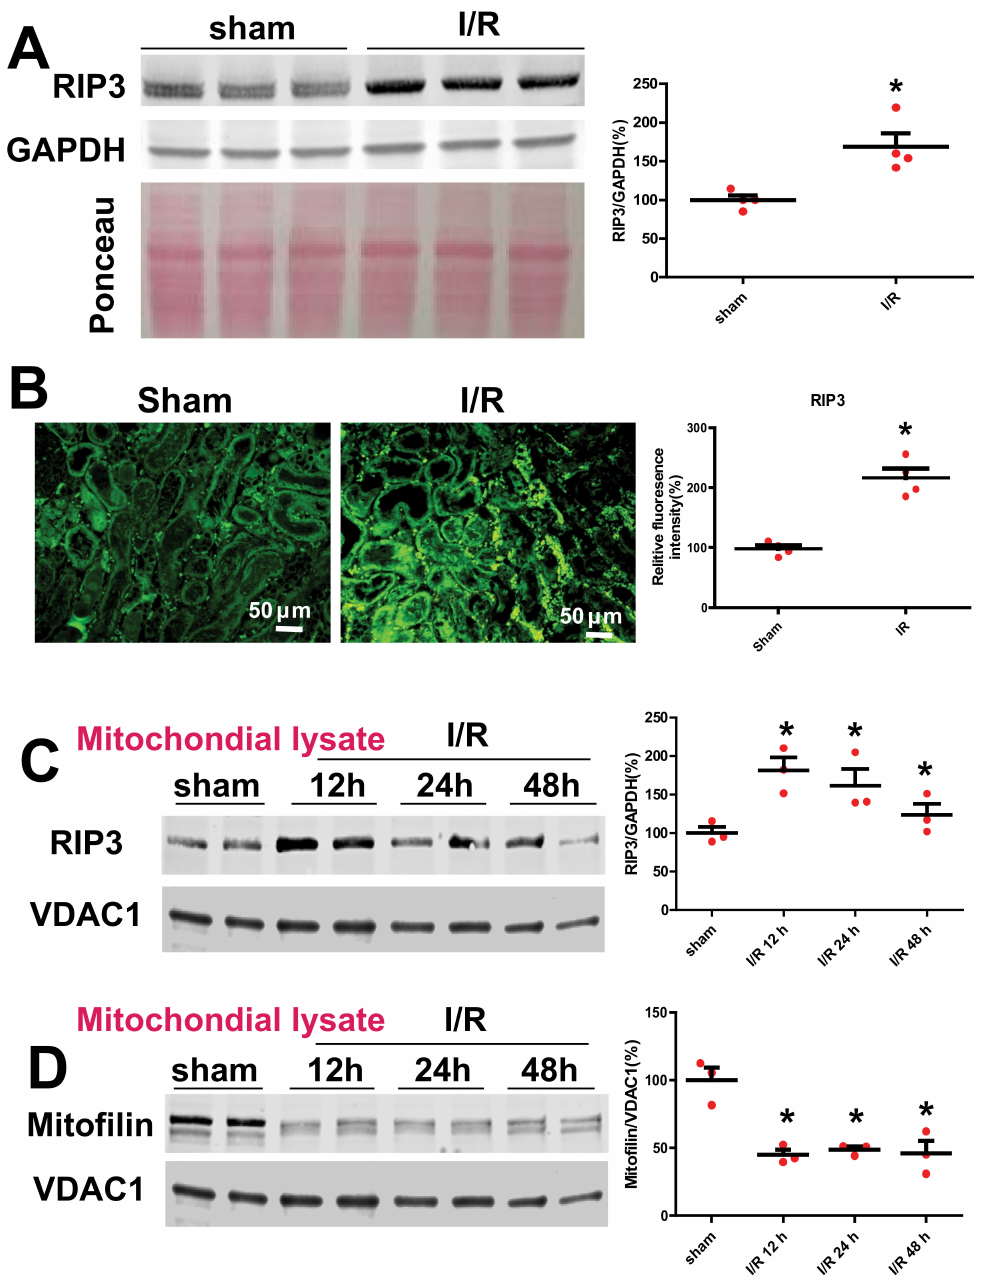
Figure 1. Renal I/R increases RIP3 expression and reduces Mitofilin levels. ( A ) Immunoblot and graph showing increases in RIP3 levels after 60 min of mono-lateral kidney ischemia followed by 12